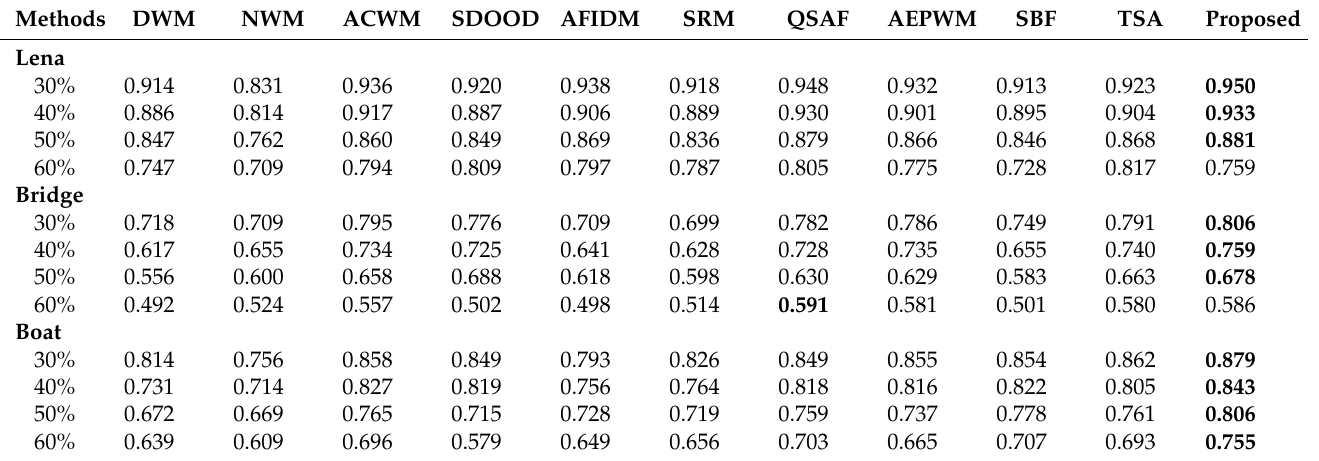
Table 2. Comparison of results in terms of SSIM for Lena, Bridge and Boat images corrupted with 30% to 60% RVIN.